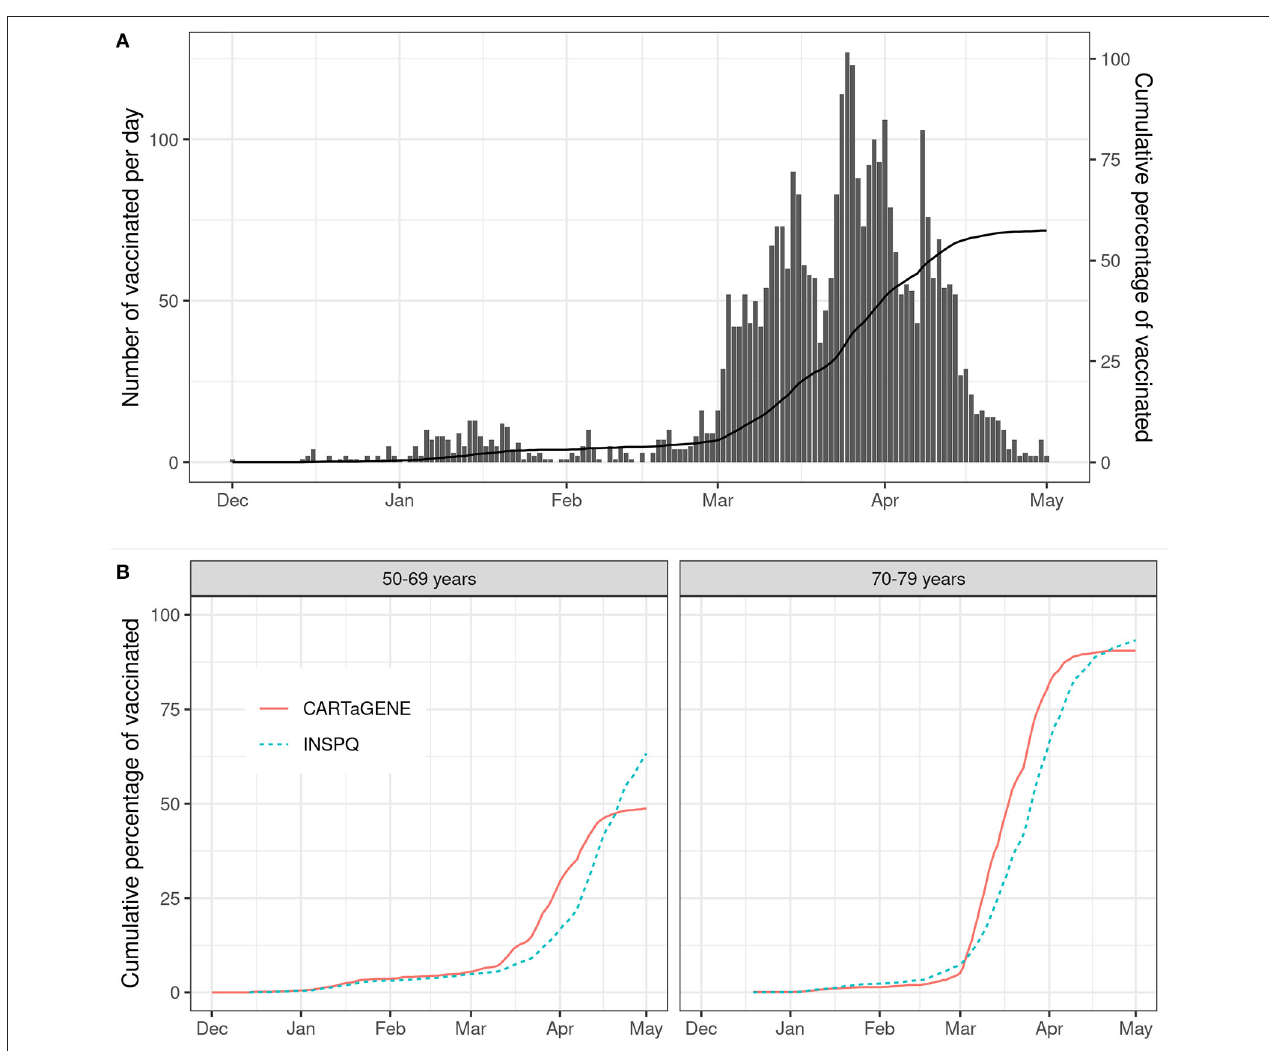
FIGURE 2 | Evolution of vaccination from December 1st 2020 to May 1st 2021. (A) Number of vaccinated per day and the cumulative percentage of vaccinated in the CARTaGENE cohort; (B) Comparison of the cumulative percentage of vaccinated between the CARTaGENE cohort and the Quebec population [source: INSPQ (3)]